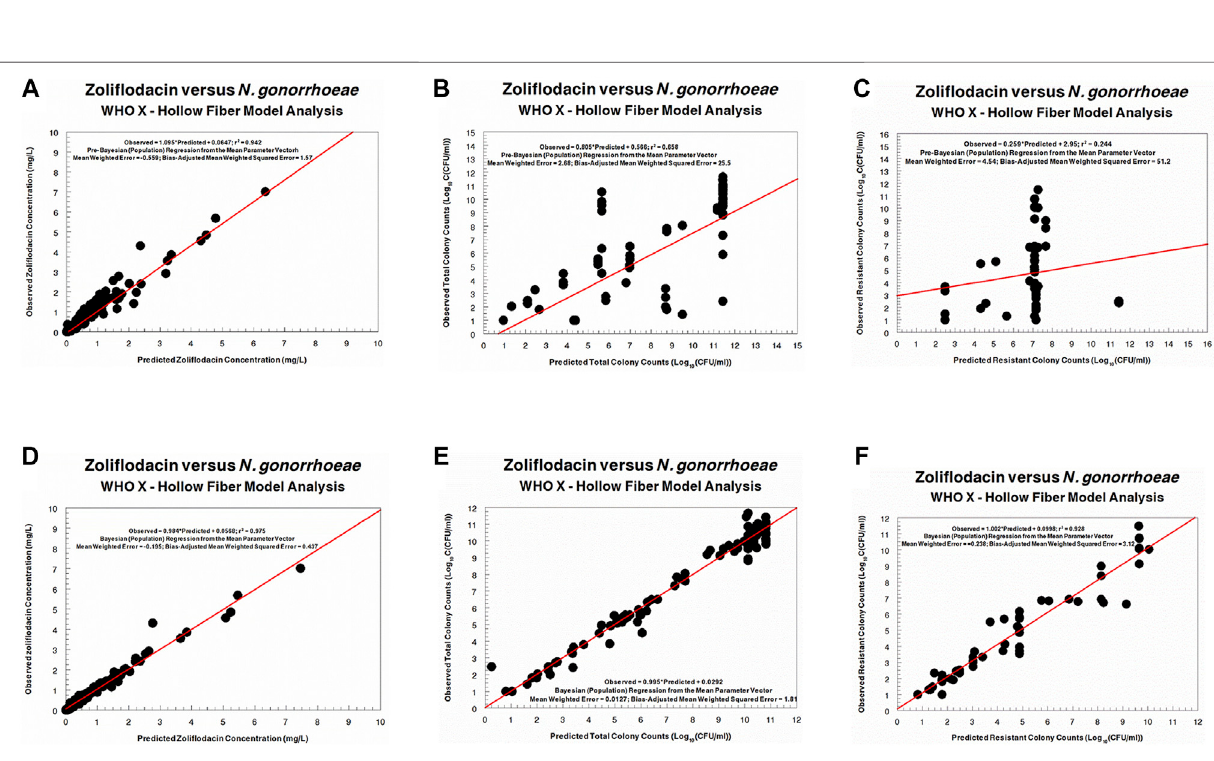
Frontiers in Pharmacology |